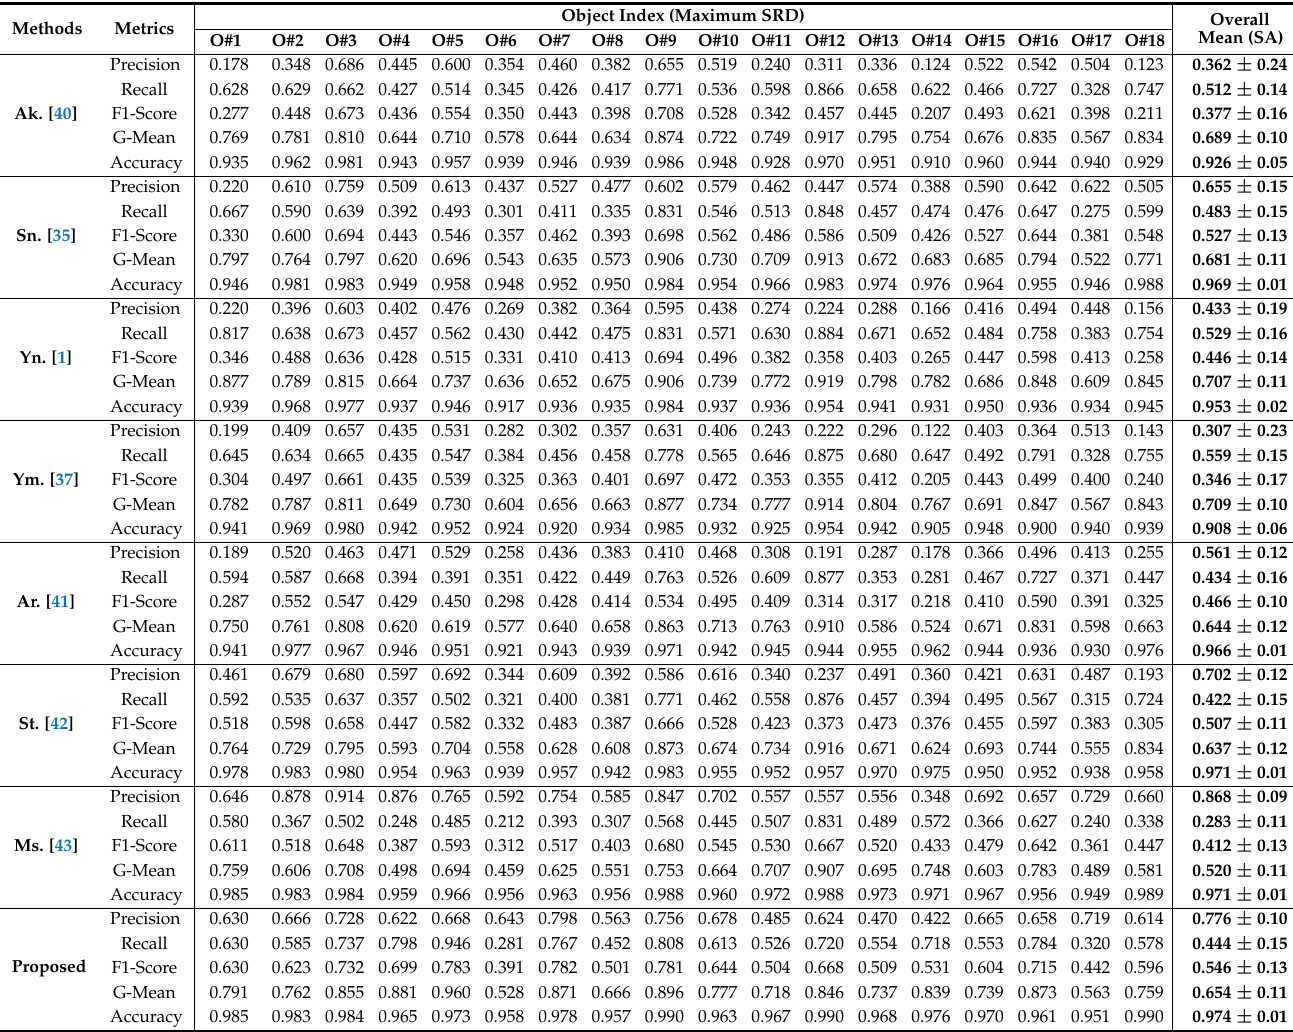
Table 1. Performance evaluation of different methods in terms of various SRD metrics for 18 objects (O#1–O#18) in MSPLFI object dataset and overall means (all sub-aperture images in 4D